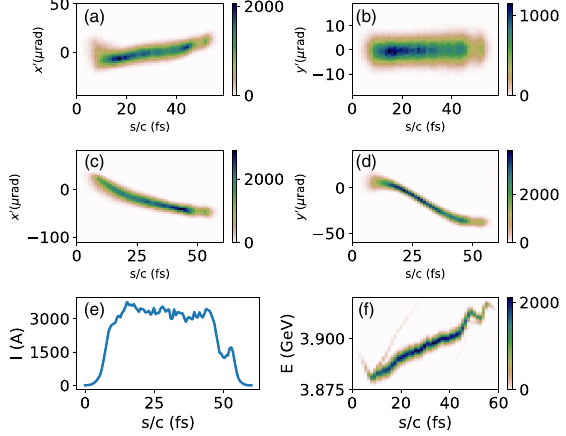
FIG. 5. (a) and (b) show the angle offsets h x 0 ð s Þi and h y 0 ð s Þi before the first dechirper. (c) and (d) show the angle offsets x 0 ð s Þ and y 0 ð s Þ and at the undulator entrance. The dechirper setup is d ¼ 430 μ m and d ¼ 380 μ m. The tail of the beam is on the x y straight trajectory when the lasing slice control is done. (a) shows CSR kicks along the bunch in x . (e) shows the current, and (f) shows the E − t distribution of the bunch at the undulator entrance. The chirp in the phase space is due to the time- dependent energy loss in the dechirper